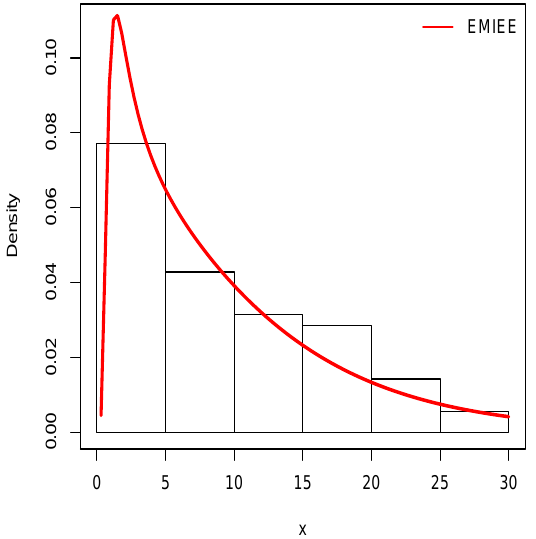
Figure 4. Estimated pdf of the EMIEE model over the histogram for the COVID-19 dataset.